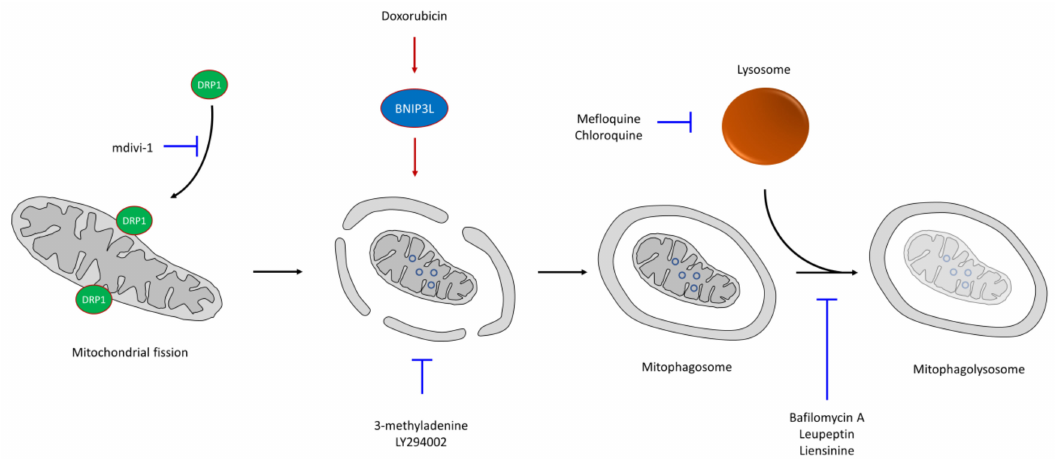
Figure 3. Mechanism of mitophagy. Mitochondrial fission is induced after DRP1 recruitment in mitochondria, a process that can be inhibited by targeting DRP1. Mitochondrial engulfment to form the mitophagolysosome can be inhibited in di ff erent steps. Thus, double membrane formation can be inhibited by drugs such as 3-methyladenine or LY294002, while it is enhanced by doxorubicin. Once the mitophagosome is formed, its fusion with lysosome can be inhibited by drugs like bafilomycin A, leupeptin or liensinine, or inhibiting lysosome formation by drugs like mefloquine or chloroquine. Blue lines correspond to autophagy / mitophagy inhibitors, red arrows refer to mitophagy activators. Cationic amphiphilic drugs (CAD), including loratadine and ebastine, can exert their e ff ect through accumulation in both mitochondria and lysosomes [214]. However, the inhibition of autophagy / mitophagy in certain steps produces increased drug sensitivity. Thus, phosphoinositol 3-kinase inhibitors, such as 3-methyladenine and LY294002, block the formation of